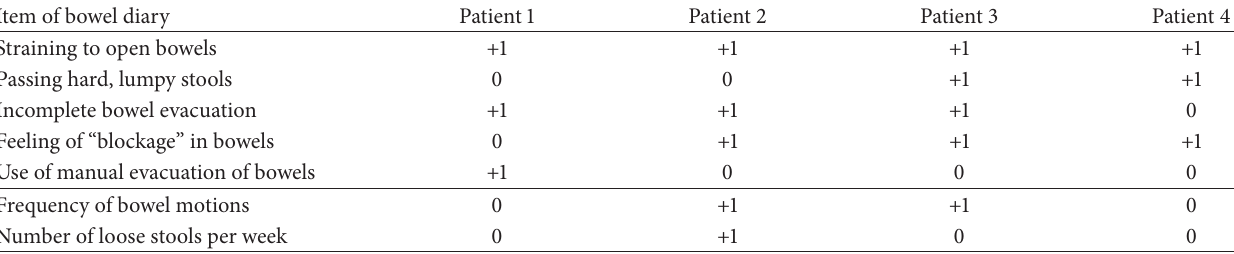
Table 3: Change at week six from baseline in the patients’ bowel